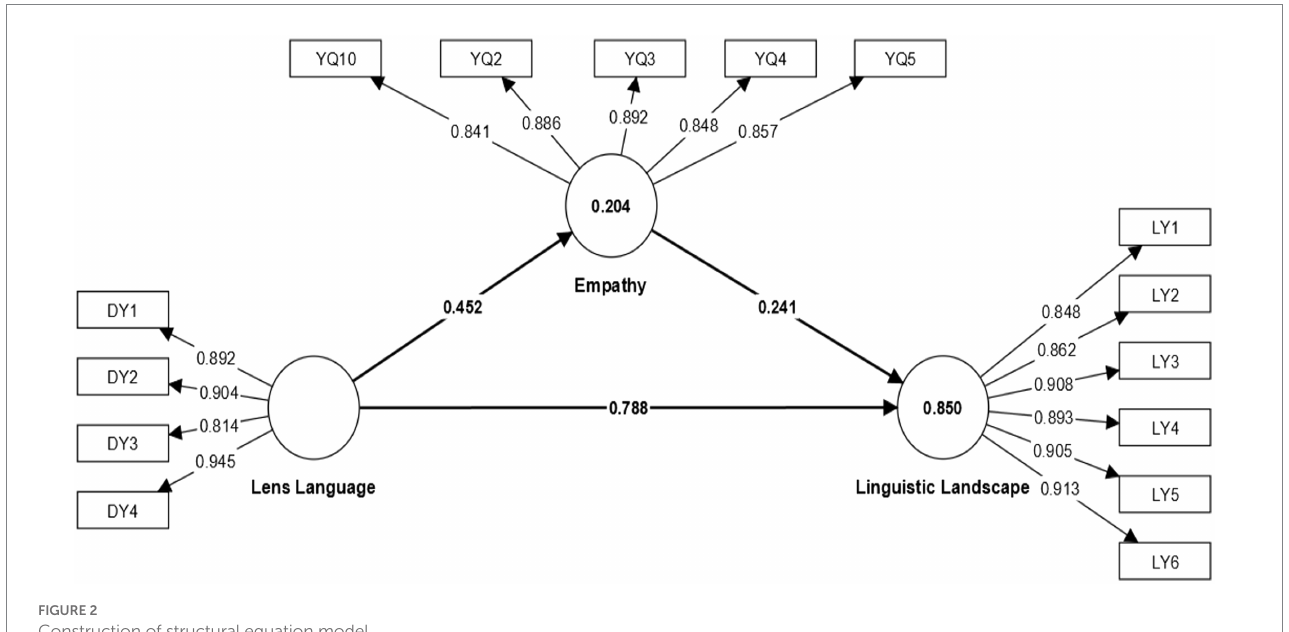
FIGURE 2 Construction of structural equation model.